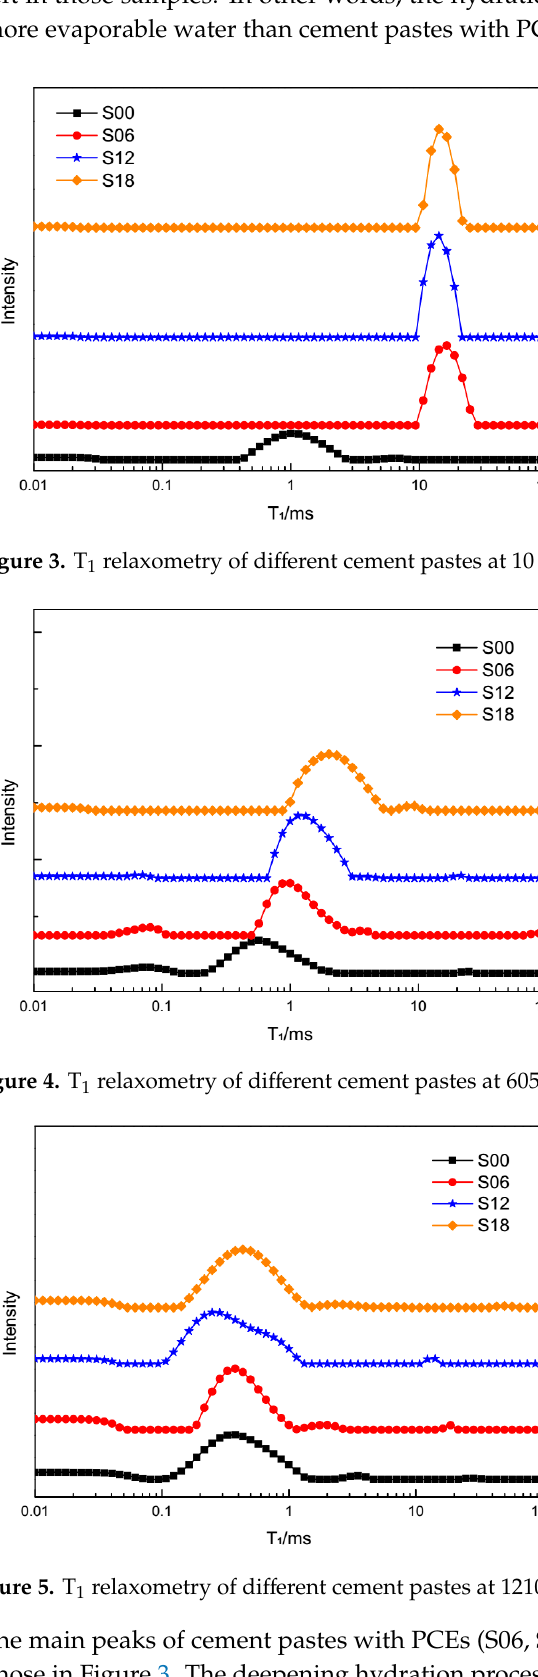
Figure 6. The total signal intensity of cement pastes at different hydration times. The time ‐ dependent evolution of weighted average T 1 is shown in Figure 7. It is shown that the time evolution of the weighted average T 1 of cement pastes with PCEs has decreased successively. The time ‐ dependent evolution of T 1 has been described according to the four ‐ stage hydration mechanism of tricalcium silicate (3CaO.SiO 2 , C 3 S), which occupies 50 wt % to 70 wt % in clinkers [50]. The first stage of C 3 S hydration is the initial period, which is within 15 min. The initial period in Figure 7 is only 5 min. During the initial period, the original hydration products form gelatinous coatings surrounding cement grains. The entire proton magnetization relaxes with a common T 1, which is due to the fast exchange between water spins in the various environments. The fast exchange may maintain the apparent relaxation homogeneity because of the fluidity of the gelatinous coating and the permeability of the gel–liquid interface [35]. Therefore, the weighted average T 1 of each sample (S00, S06, S12, S18) seems unchanged from 10 min to 15 min in Figure 7. There are still some differences among the initial values of weighted average T 1 at 10 min. The order of these initial values is against the dosages of PCEs. The order of weighted average T 1 at 10 min is the feedback to gelatinous coatings thickness of cement hydrates, which has means that the coatings of hydrates in plain cement pastes were the thickest. The second stage of C 3 S hydration is the slow ‐ reaction (dormant) period, which is from 15 min to 120 min. During the dormant period, the weighted average T 1 of each sample (S00, S06, S12, S18)